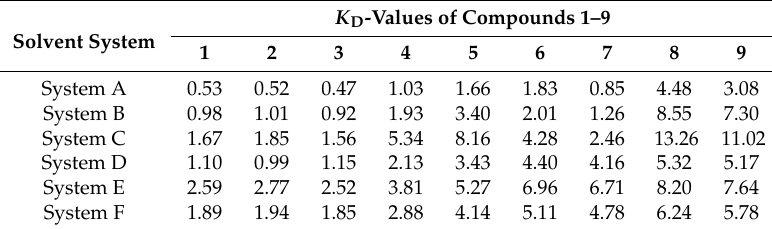
Table 2. The K D -values of target components measured in different solvent systems. Solvent System